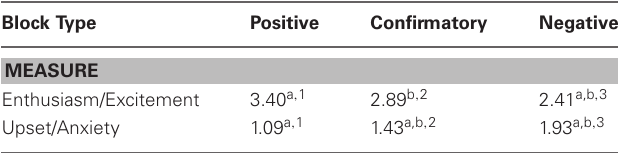
Table 1 | Marginal means for affect measures by block